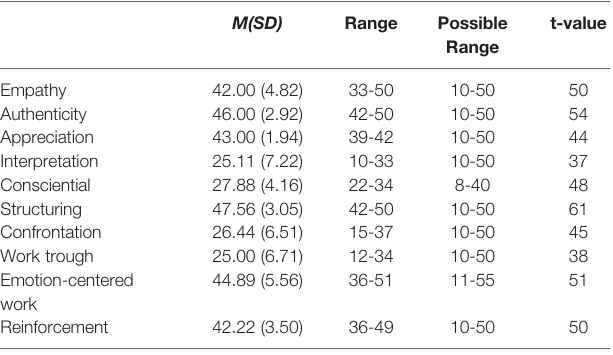
TABLE 1 | Therapeutic process according to BFTB: Means and standard deviations, range, possible range and t-values at t2 ( n = 9). M(SD) Range Possible t-value Range